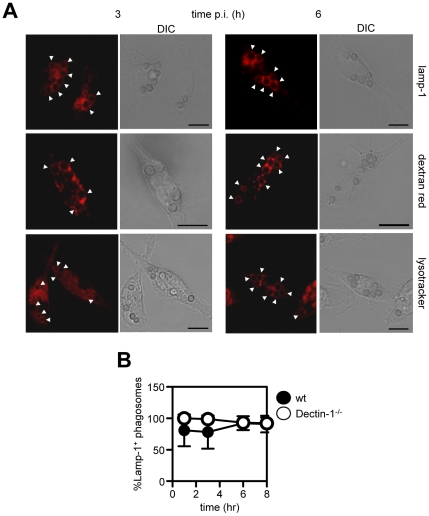
Phagosomes containing Aspergillus resting conidia mature normally into phagolysosomes.(A) Immunofluorescent confocal analysis of Aspergillus conidia phagosomes in thioglycollate-elicited macrophages at 3 and 6 hr after infection, and examined for acquisition of LAMP-1, preloaded Dextran-red and fluorescence of lysotracker, indicating acidification. Arrowheads point to the location of conidia. Scale bar indicates 10 µm. (B) Kinetic analysis, determined by immunofluorescence microscopy, of the acquisition of Lamp-1 to conidial phagosomes in thioglycollate-elicited macrophages from wild type (black circles) and Dectin-1−/− (white circles) mice. Data shown are mean ± SD. The data shown are representative of at least two independent experiments.